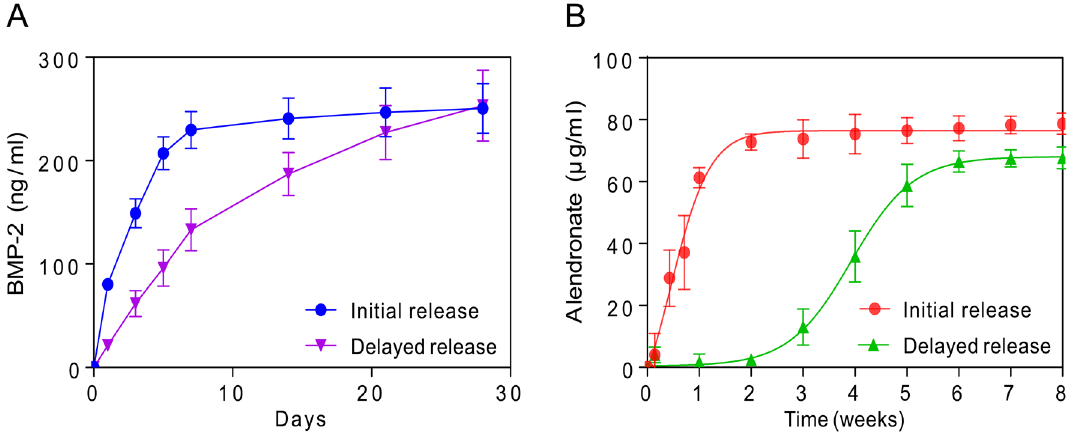
Figure 3. Initial or delayed drug release of BMP-2 ( A ) and alendronate ( B ) depending on the presence of PLGA microparticles in CHAS.